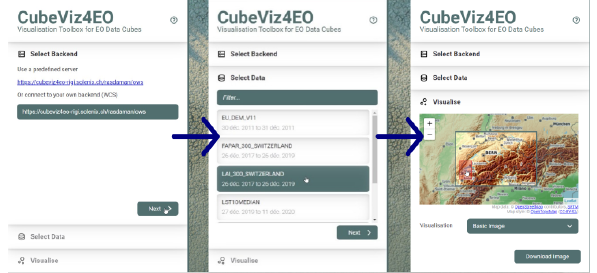
Figure 19. Toolbox process: accessing raw data server (left); setting up specific data set (middle); selecting regions (right).